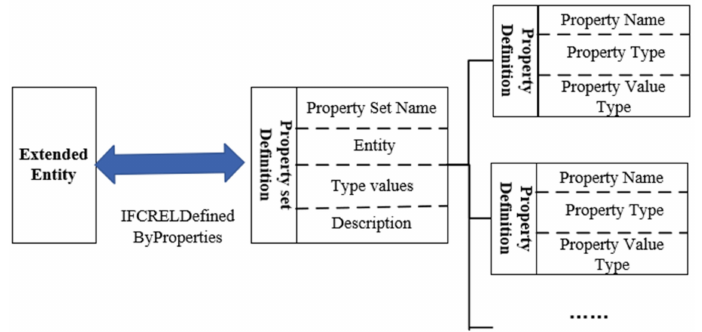
Figure 6. IFC Extension Process Based on Attribute